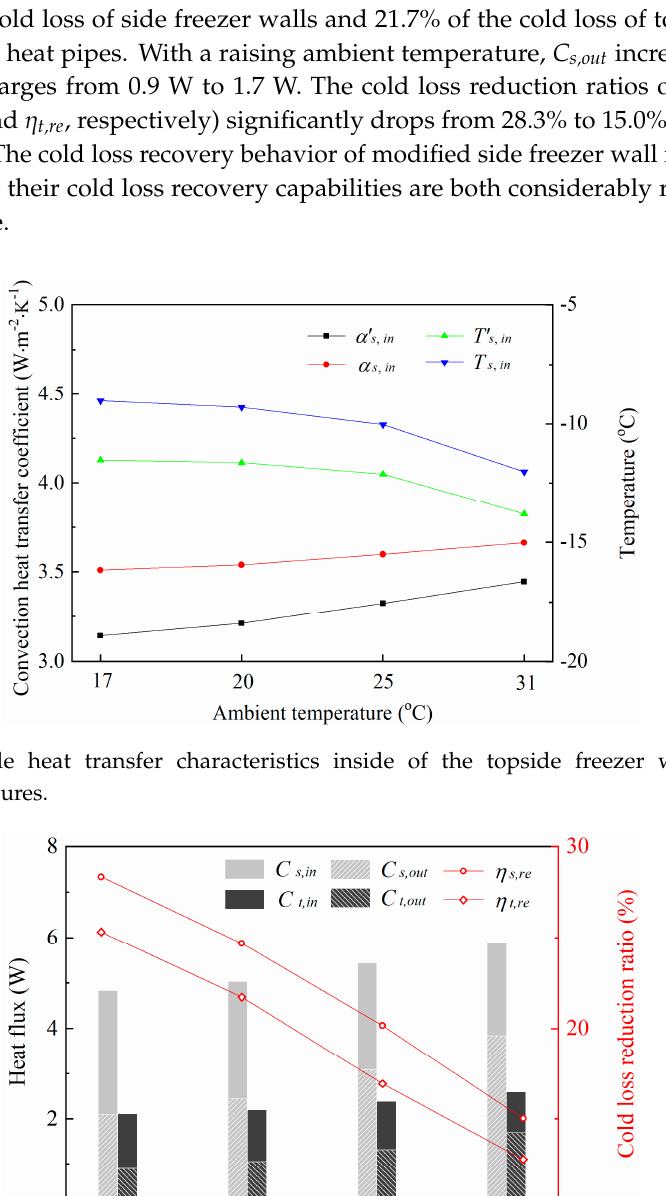
Figure 7. Cold loss recovery performances of modified freezer at various ambient temperatures. 5.2. Performances at Different Temperature Gears When the ambient temperatures, A eva and X in , are fixed to 25.0 °C, 0.146 m 2 , and 16%, respectively, and the temperature gears are given as A~D, the measured boundary conditions are utilized to further compare the performances of original and improved refrigerators. The representative heat transfer parameters of original and improved side freezer walls are shown in Figure 8. As the temperature gear is adjusted from A to D, the inside convective heat transfer coefficient for the original side wall ( α ' s , in ) remains close to 3.34 W·m − 2 ·K − 1 , whereas that for the modified one ( α′ s , in ) remains at about 3.59 W·m − 2 ·K − 1 . The inside surface temperature for the modified side wall ( T s , in ) raises from − 12.1 °C to − 9.6 °C; and the inside surface temperature for the original side wall ( T' s , in ) raises from − 13.9 °C to − 11.8 °C. When the temperature gear changes from A to D, T s , in remains higher than T' s , in , and their difference slightly enlarges from 1.8 °C to 2.1 °C. The